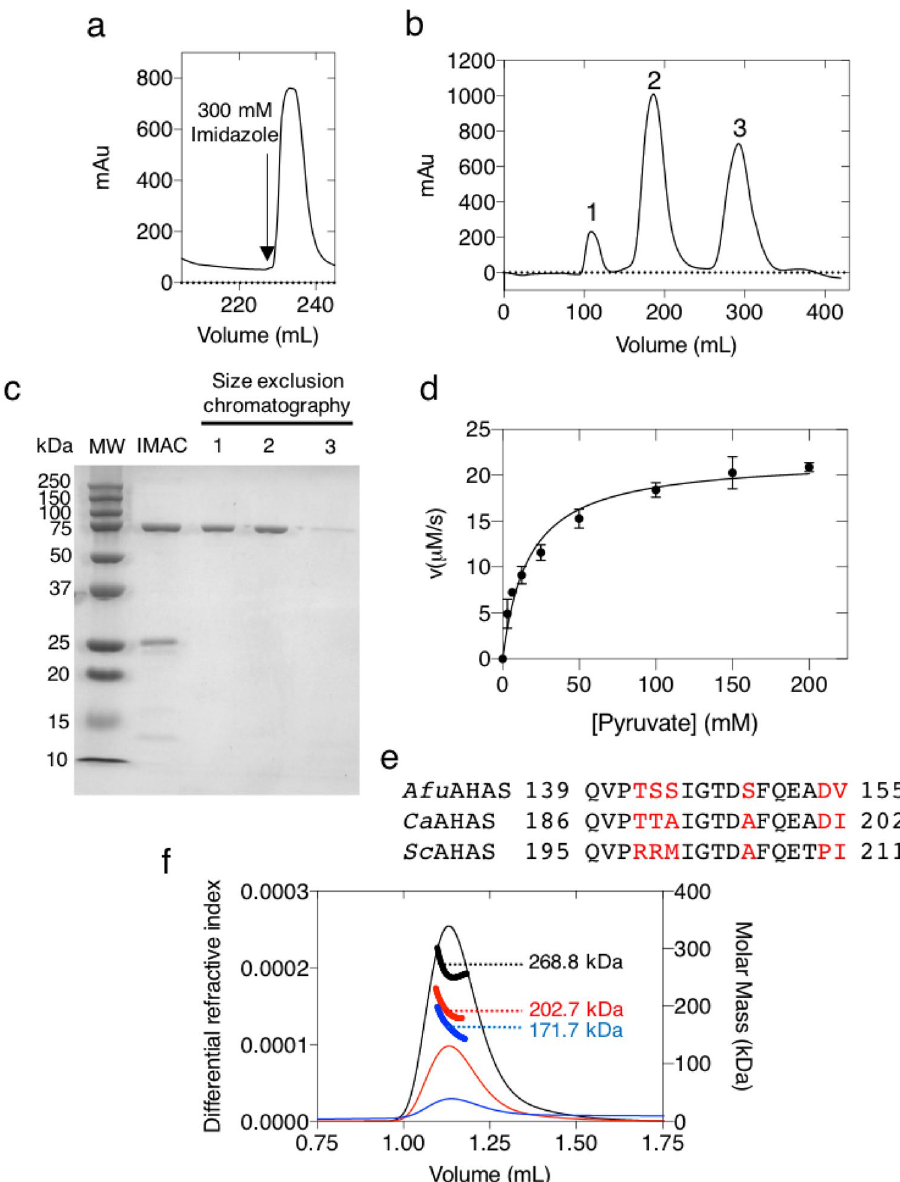
Figure 2. Purification of Afu AHAS and determination of its quaternary structure. ( a ) IMAC purification from cell lysate. ( b ) Size exclusion chromatography of the IMAC eluate using a Sephacryl-200-HR column (Pharmacia). Peak 1 corresponds to the void volume. Peak 2 has enzymatic activity. Peak 3 represents the cofactor salts. ( c ) Cropped SDS-PAGE for the purification of Afu AHAS. MW Molecular weight marker, IMAC eluate; Lanes 1, 2 and 3 correspond to peaks 1, 2 and 3 of the size exclusion chromatogram. See Supplementary Fig. 1 for uncropped version. ( d ) Pyruvate saturation curve for Afu AHAS. The data (measured in triplicate) were obtained using a continuous spectrophotometric method. The solid curve shows the best fit to the Michaelis– Menten equation with an R 2 value of 0.97. ( e ) Comparison of the Q-loop sequences in the catalytic subunit between Afu AHAS, Ca AHAS and Sc AHAS. ( f ) SEC-MALS of peak 2 at three different loading concentrations (1, 5, 10 mg/mL, in blue, red and black, respectively) using a Superdex 200 Increase 5/150 GL column. The MALS data were processed using the ASTRA software (Wyatt